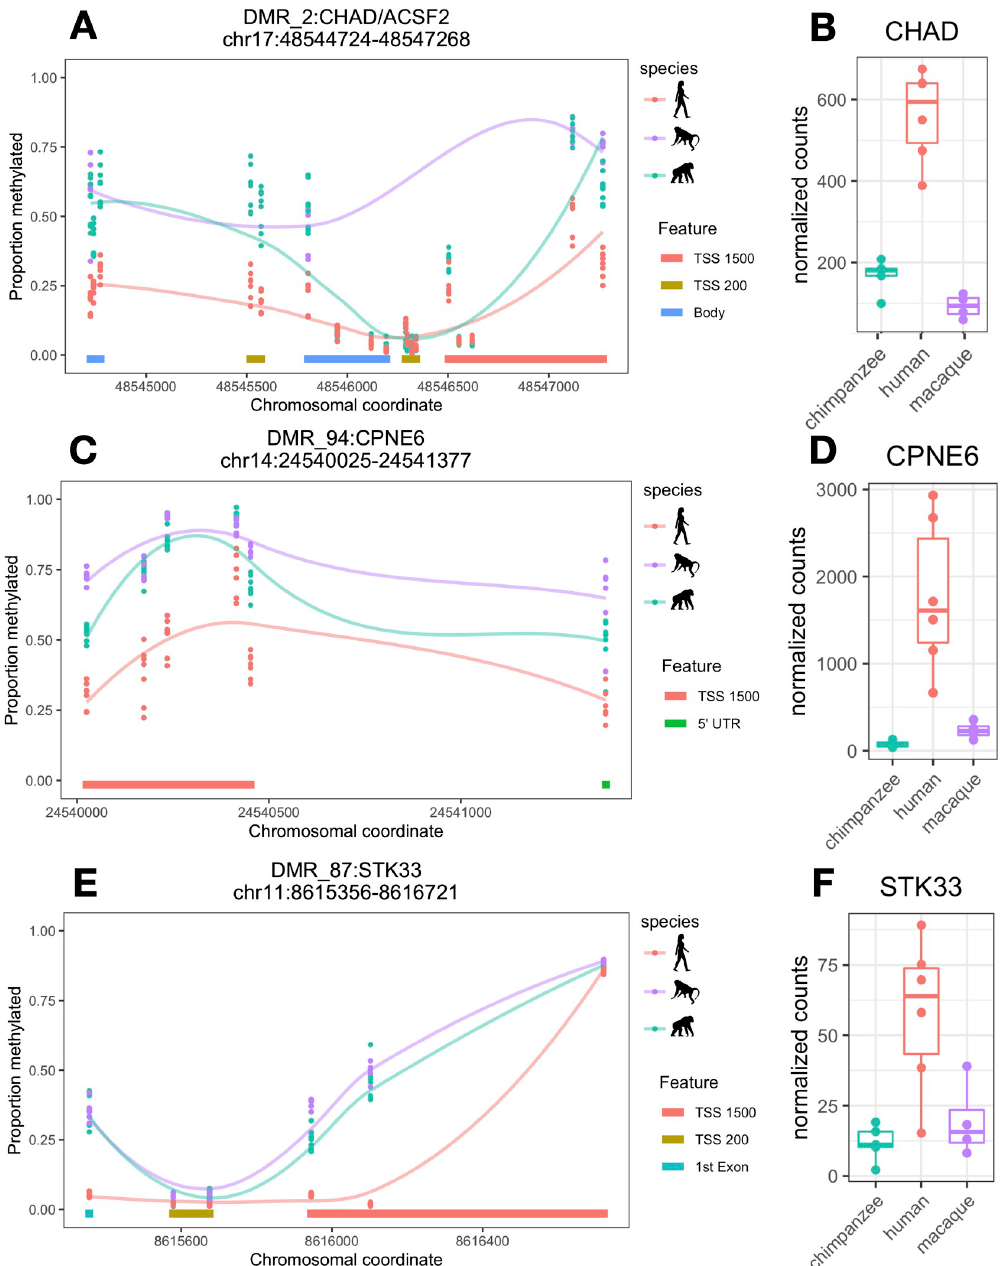
Fig 4. Cerebellum-specific human regDMRs and gene expression levels for CHAD , CPNE6 , and STK33 . A = CHAD methylation, B = CHAD gene expression, C = CPNE6 methylation, D = CPNE6 gene expression, E = STK33 methylation, and F = STK33 gene expression. Lines are loess smoothed methylation values for each species across the DMR and each point represents raw methylation values for each individual at each CpG site within the DMR ranges. TSS200 = within 200 bp of a transcription start site and TSS1500 within 1500 bp of a transcription start site. Chromosomal coordinates are in base pairs and refer to human genome build hg19.